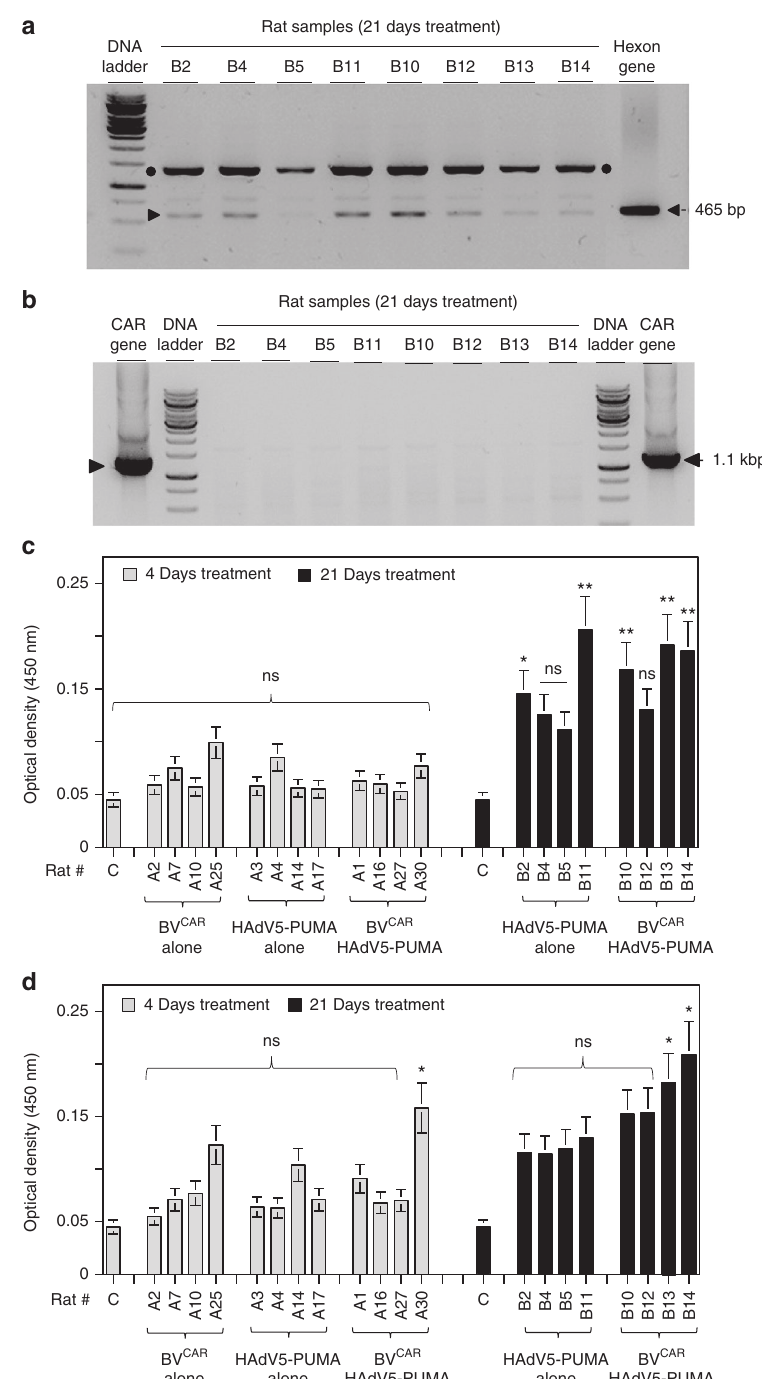
Fig. 8 Analysis of vector persistence and immune response to vectors. a The HAdV5-PUMA and BV CAR DNA genomes in synovial tissues were extracted from synovial tissues samples of rats killed at day 21 after intra-articular administration of HAdV5-PUMA alone (B2, B4, B5 and B11) or BV CAR HAdV5- PUMA (B10, B12, B13 and B14), and used for PCR analysis to detect the viral genomes. a The 465-bp ampli fi ed fragment corresponding to the HAdV5 hexon gene ( a , arrowhead ) was found in all the samples and in the positive control. Note the occurrence of a non-speci fi c ampli fi ed fragment of 1500 bp ( black dots ). b , For the BV CAR genome, no speci fi c band of 1.1 kbp, corresponding to the baculovirus CAR gene was detected in any of the samples, but was present in the positive control. b To evaluate the immune response of the treated animals to BV CAR and HAdV5-PUMA vectors, the sera of the animals treated for 4 days and 21 days with HAdV5-PUMA alone or with BV CAR HAdV5-PUMA were analysed by ELISA for the presence of antibodies against adenovirus and baculovirus. A single serum dilution (1:10) was used for all samples. No signi fi cant adenovirus or baculovirus antibodies were detected in the sera of the animals treated for 4 days ( grey bars , c , d ). In the animal group treated for 21-days, adenovirus antibodies were detected in the sera of 5/8 animals ( black bars , c ) and baculovirus antibodies detected in the sera of 2/8 animals ( black bars , d ). Similar results were obtained in an independent